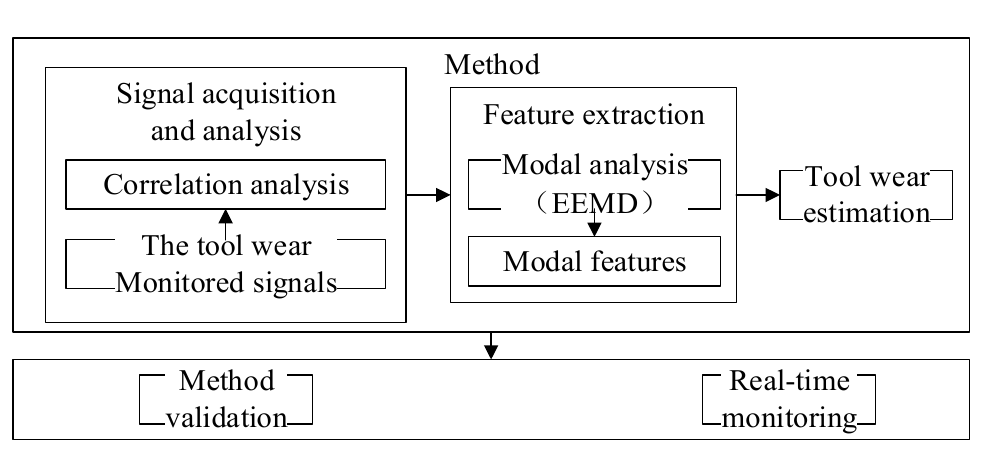
Figure 1. The flowchart of the method.